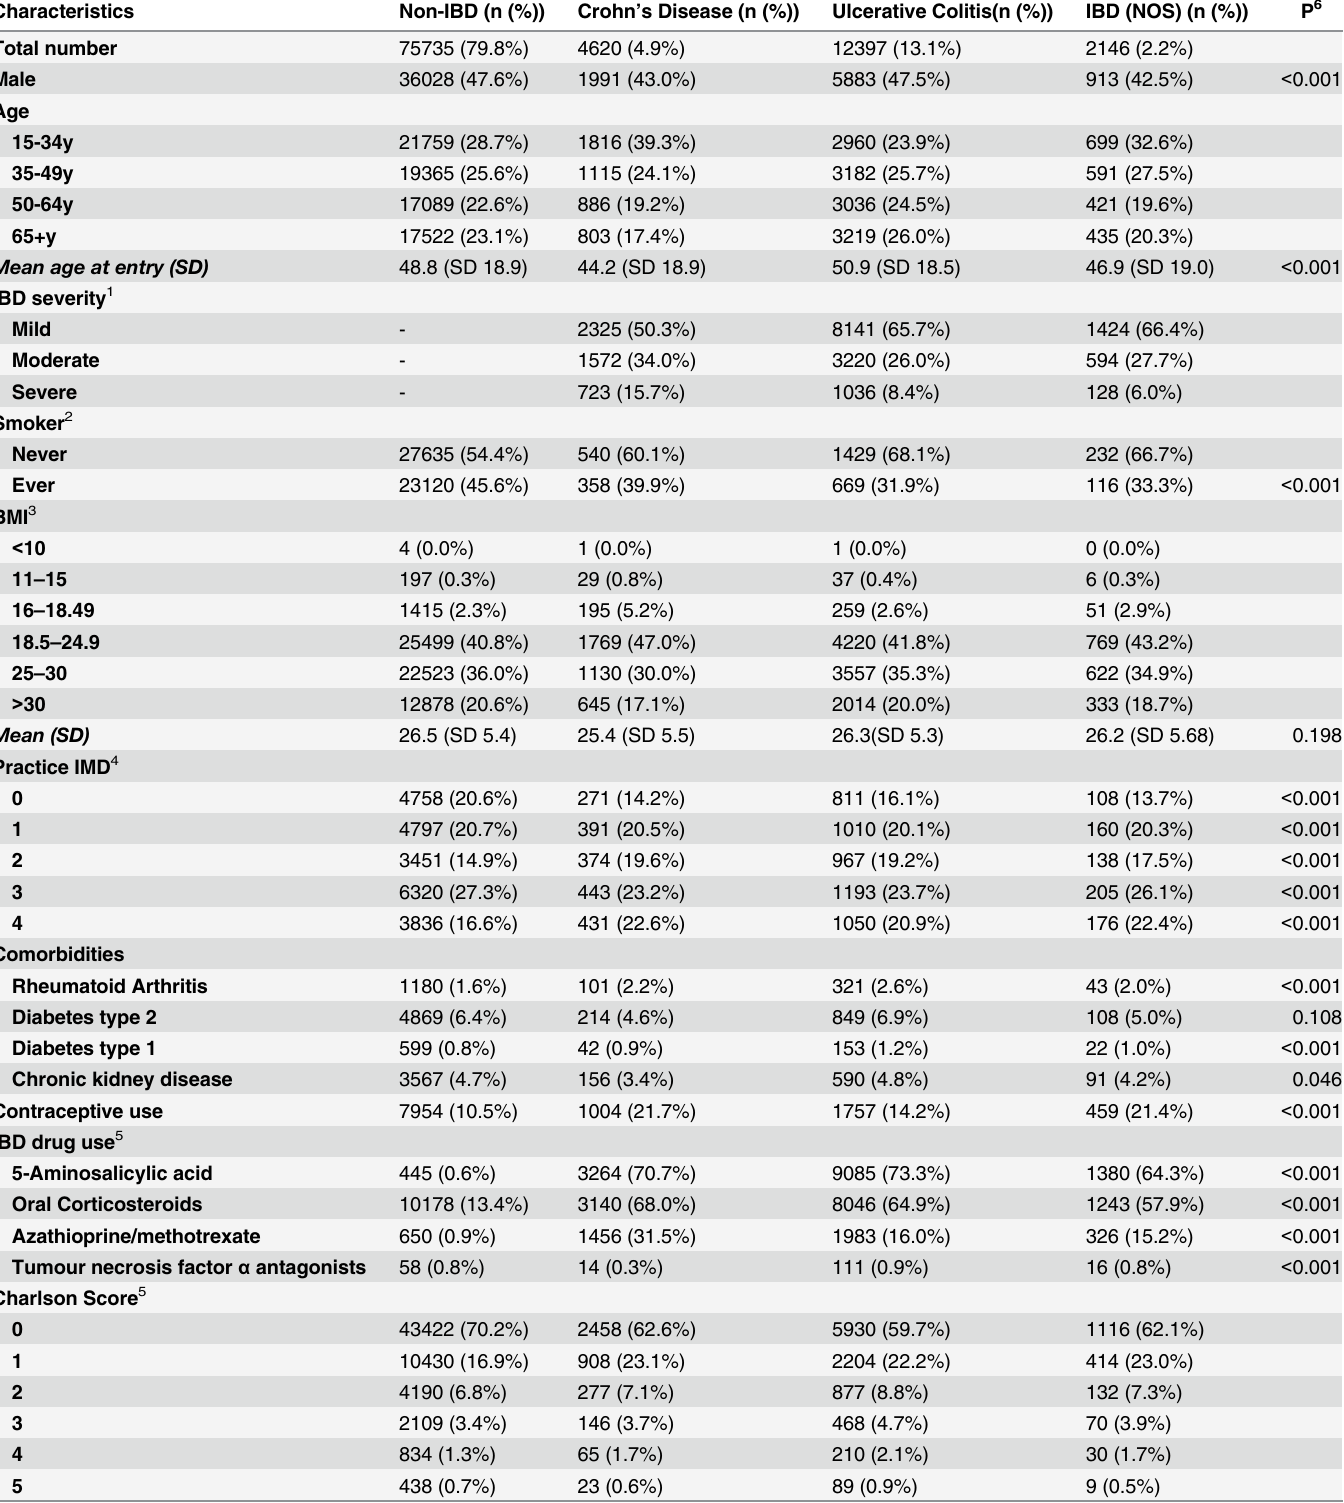
Table 1. COHORT A characteristics comparing non-IBD controls with IBD cases ( (cid:1) 15